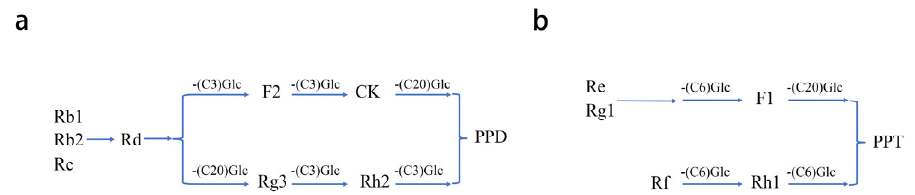
( c ) oleanolic acid type; and ( d ) ocotillo type.